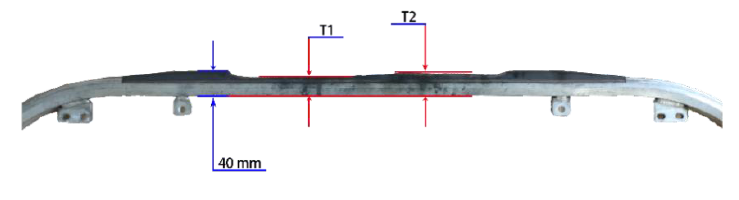
Figure 2. The carbon contact strip.